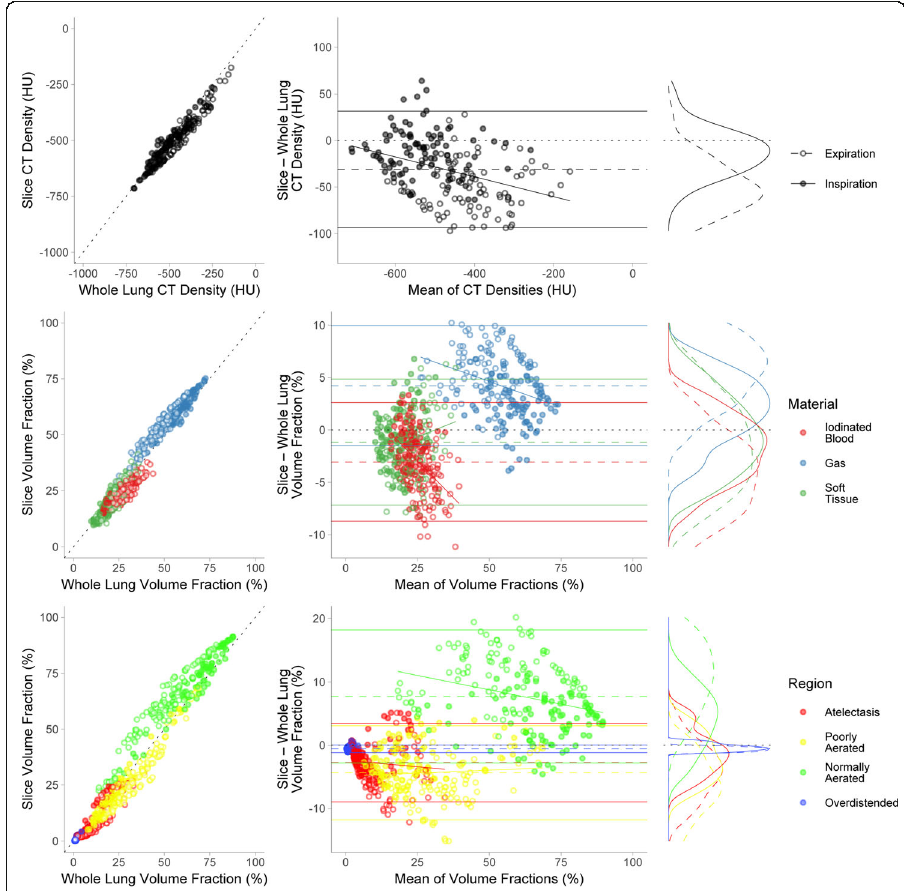
graphs and the line of no difference in the Bland-Altman analysis. Mean difference is represented by dashed line with solid lines representing 95% limits of agreement in the Bland-Altman analysis. The greatest effect on the discrepancy between dynamic CT and whole-lung values was noted between inspiration (filled circles) and expiration (empty circles): thus, these points are highlighted separately. Right-hand column provides density distributions for the discrepancies, again separated by inspiration (solid line) and expiration (dashed line). In all eight variables, inspiration moves the distribution closer to the line of no